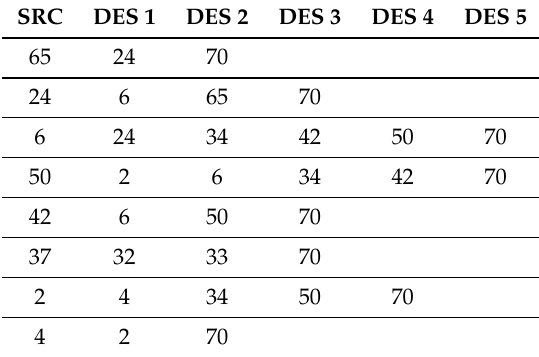
Table 2. Src and Des for V (cid:42)(cid:41) V Session.